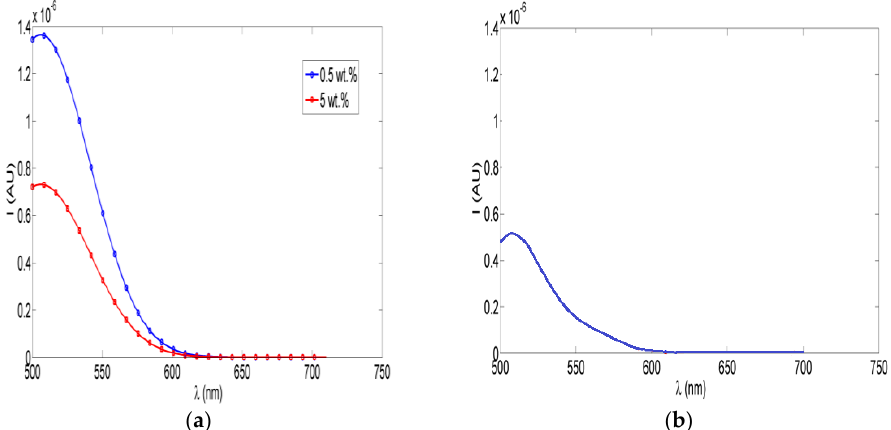
Figure 5. ( a ) The absorbance dispersion of spin-coated ceria NPs at 1 wt % on crosslinked PVA NFs, and ( b ) the corresponding allowed direct bandgap.